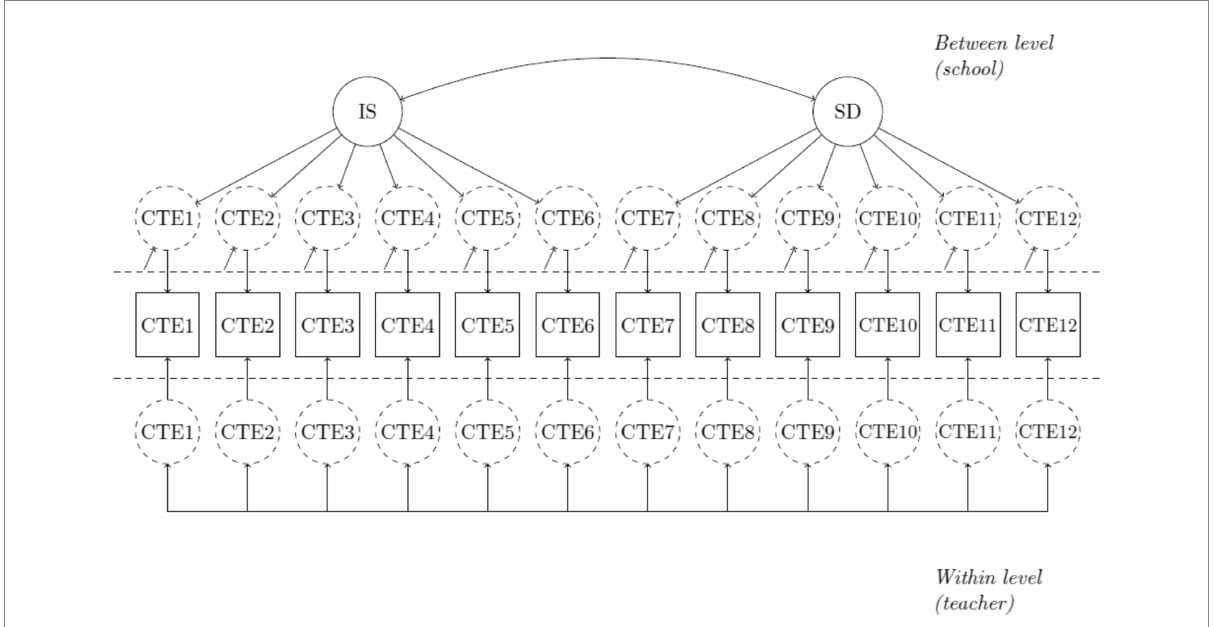
FIGURE 1 Two-factor measurement model (two school-level shared constructs). IS = instructional strategy; SD = student discipline; CTE = collective teacher efficacy.